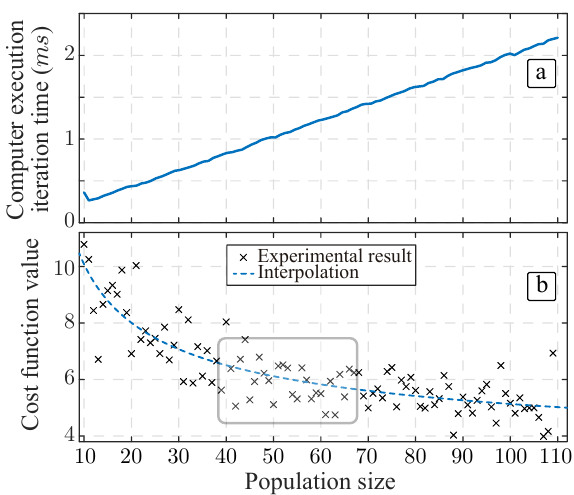
Figure 3. MATLAB implementation of the EMA being applied to the Selective Harmonic Mitigation (SHM) problem considering several population sizes: ( a ) EMA execution time per iteration in a computer; ( b ) cost function value after 300 iterations.